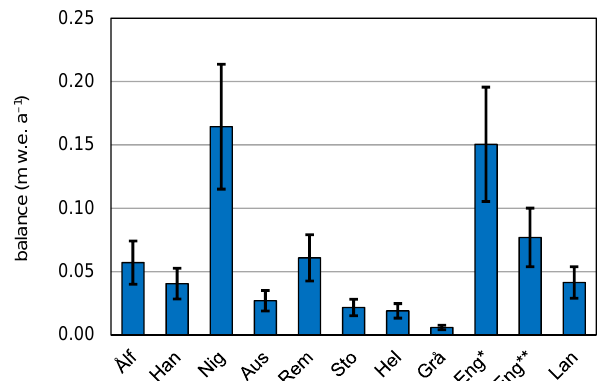
Figure 6. Calculated internal ablation for the 10 study glaciers. The values are the annual mean for the reference period 1989–2013. Cal- culations are divided in two periods for Engabreen, ∗ 1989–1992 and ∗∗ 1993–2013, since the subglacial water was captured by a tunnel under the glacier from 1993. Error bars are one-third of the calcu- lated value.